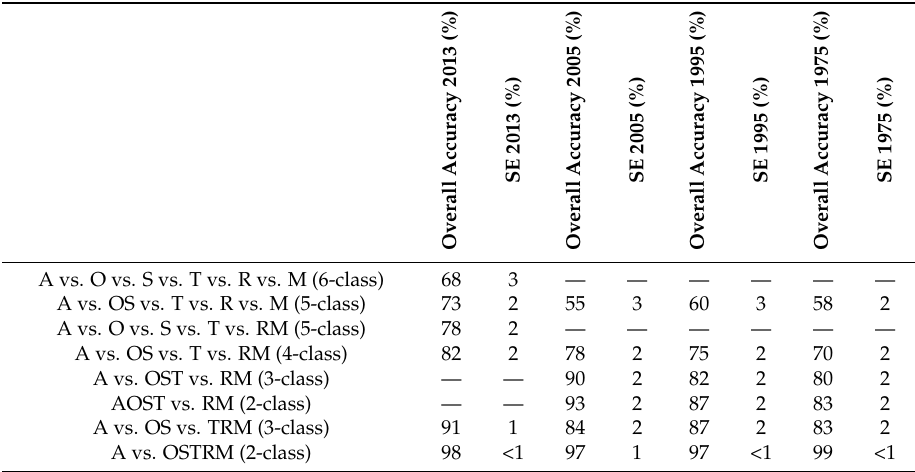
Table 1. Overall accuracies and standard errors (SE) of the initial 2013, 2005, 1995, and 1975 classifications. A = Alpine, O = Open, S = Stand Initiation, T = Thin, R = Advanced Regeneration, M = Mature. Only the 2013 classifications separated Open from Stand Initiation. The 5- and 6-class classification accuracies were notably lower than those of the classifications with fewer classes, likely because of the difficulty in distinguishing similar cover types from one another, i.e., Open versus Stand Initiation or Advanced Regeneration versus Mature. Validation points for 2013, 2005, and 1995 were interpreted from GoogleEarth imagery. Validation points for 1975 were interpreted from digital aerial photographs. Full error matrices can be seen in Supplementary Material, Tables